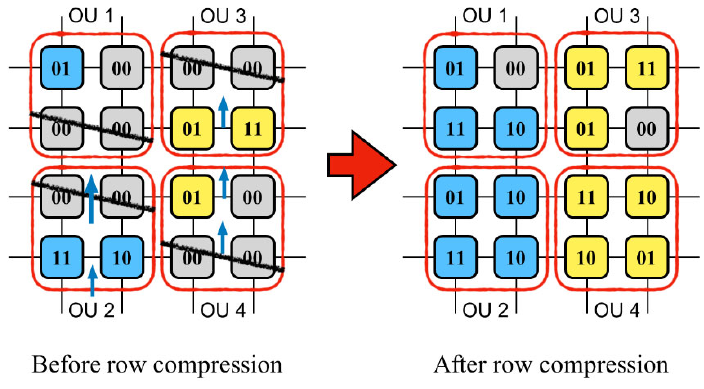
Figure 4. Crossbar array before and after row compression [58]. Comparing SRE with an idealized design (i.e., ISAAC [59]), SRE is able to provide better performance for NN models such as CIFAR-10, CaffeNet and GoogLeNet. In addition, SRE can save an average of 67.0% of energy over the ISAAC design. As for evaluation with other neural network models, SRE is capable of providing an average speedup of 13.1